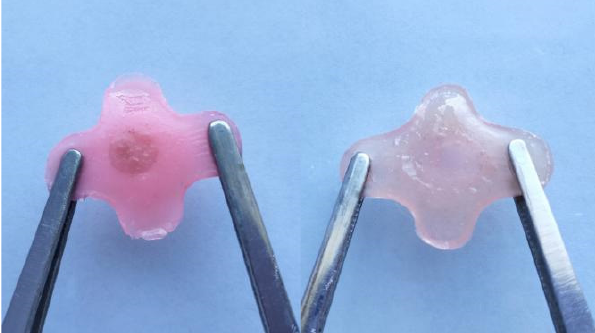
Figure 7. Stretch test.